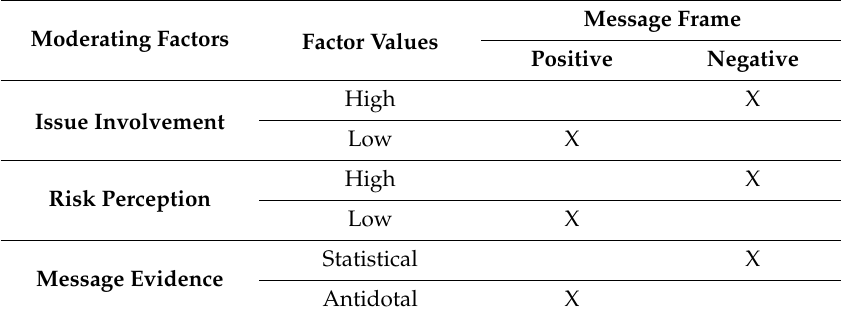
Table 11. Summary of moderating e ff ects on message framing and message e ff